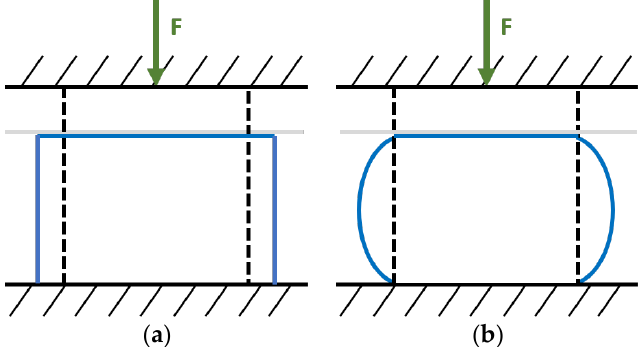
Figure 1. Compression behaviour of a rubber block: ( a ) no friction between surfaces; ( b ) between bonded surfaces.